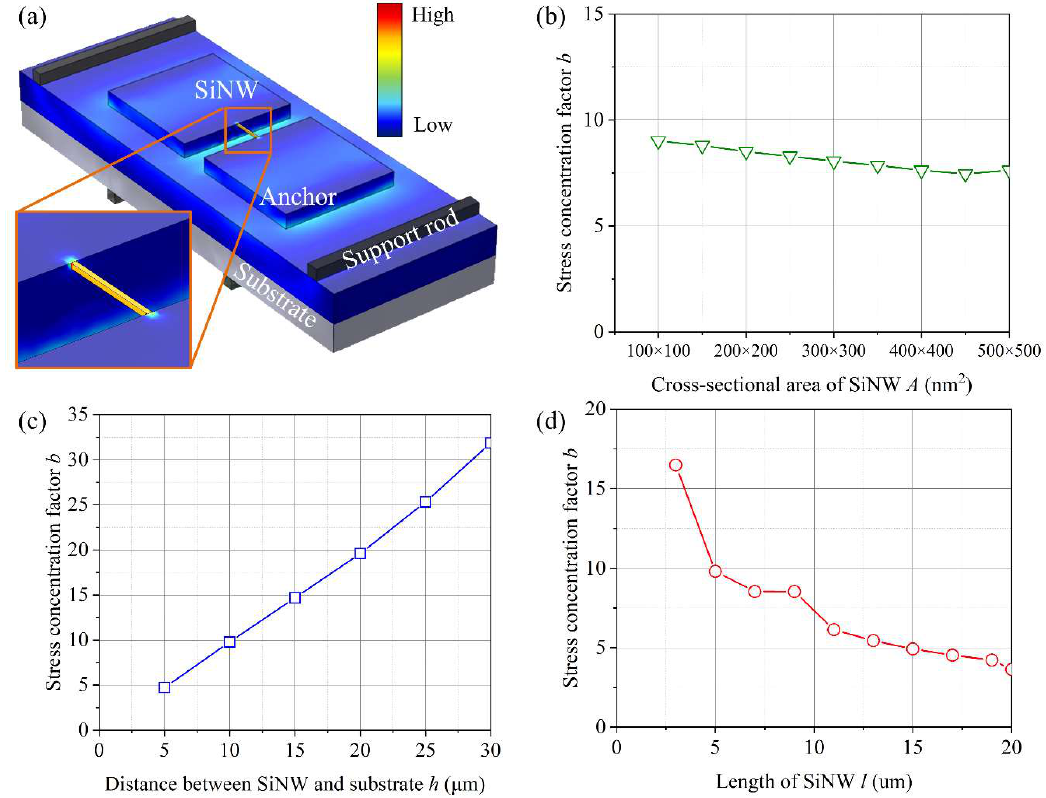
Table 1. Material parameters of silicon in finite element method (FEM) simulation.